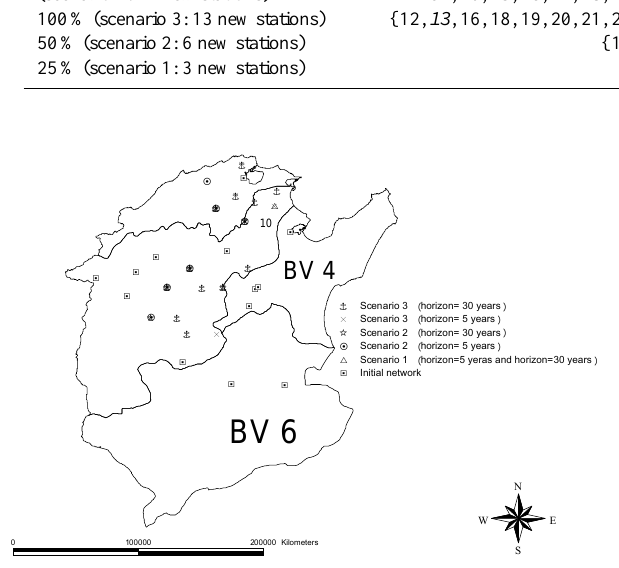
Table 6. Robust solutions. The locations which are different for the two horizons are in italics. Increasing the existing network by horizon = 5 yr horizon = 30 yr Normative density of the WMO (160%)